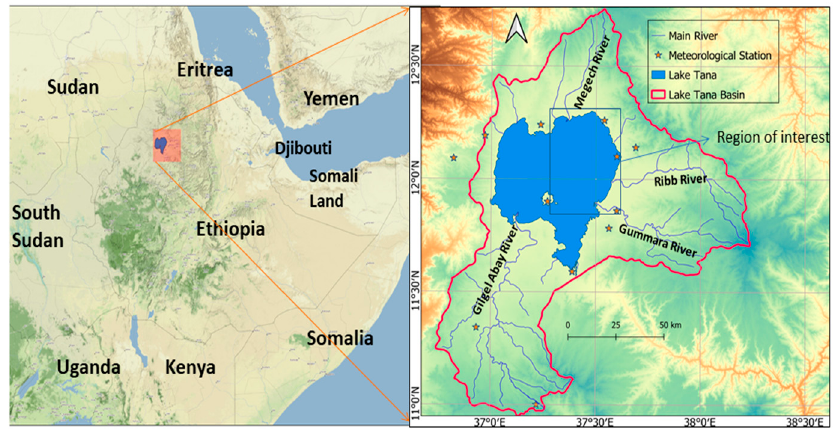
Figure 1. Map of the Horn of Africa indicating the location of Lake Tana (Ethiopia), indicating its basin (marked with a red line) and its major tributaries (blue lines) within the region of interest. The location of the meteorological stations is also indicated.